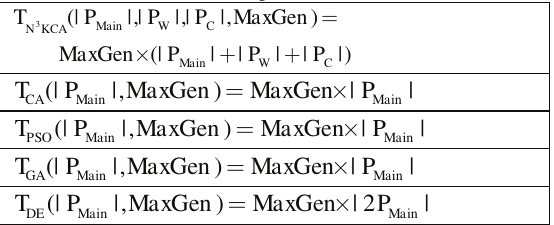
Table 3. The complexity of all algorithms used in the comparison